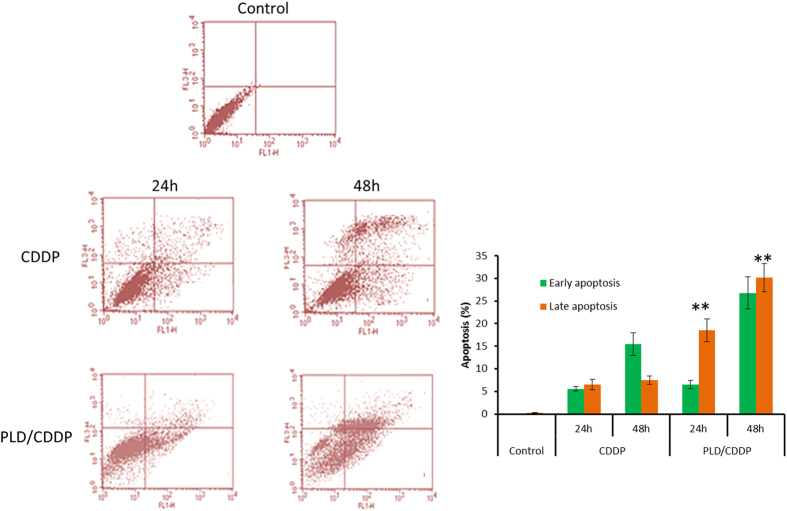
Annexin V/PI based apoptosis analysis in MG63 cancer cells.The cells were treated with free CDDP and PLD/CDDP and incubated for 24 and 48 h, respectively. The respective cell percentages in early and late apoptosis for different time period are presented in the bar graph. Data are expressed as standard deviation of the mean and n = 4. **p < 0.01 is the statistical difference between apoptosis potential of CDDP and CDDP/PLD treated group.